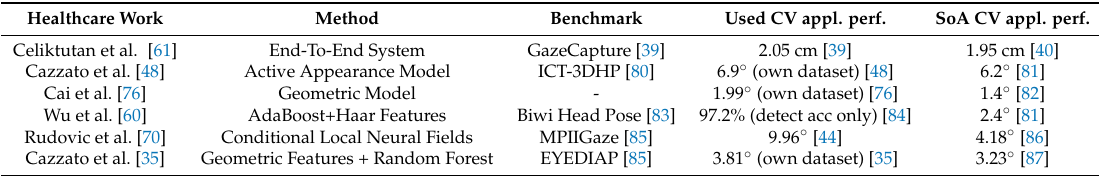
Table 1. Eye Analysis of computer vision approaches for the healthcare-related works and their comparison with up-to-date works in the state-of-the-art (SoA). Healthcare Work Method Used CV appl.